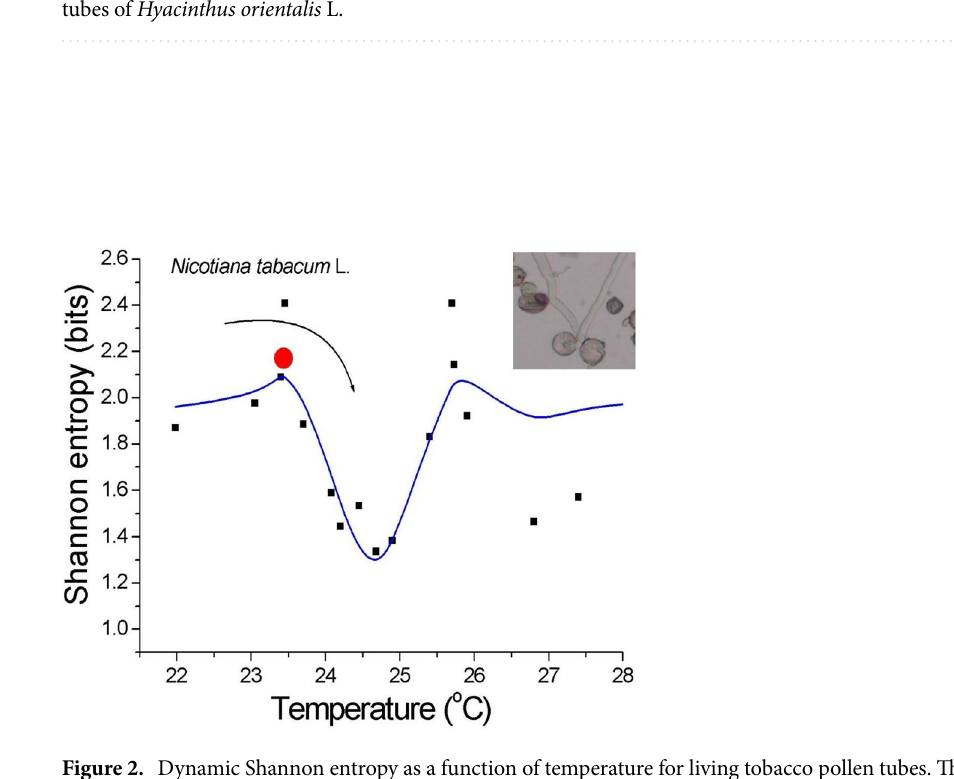
Figure 2. Dynamic Shannon entropy as a function of temperature for living tobacco pollen tubes. The data points (solid squares), calculated separately in the R programming language from the original time series, were interpolated using the sinc function and showed a zero-bias peak and splitting (bound state) at criticality. The red ball with the arrow, representing thermally activated proton over-the-barrier hopping dynamics, points to the attractor basin, which can be interpreted as a 2H + ion(s) energy gap ( (cid:31) ) that was approximately 2.25 K (0.00019(1) eV) wide, which indicated the readiness of the pollen tubes for an extreme (fast) and stable elongation at a critical range. Note the clear local maxima that can be interpreted as potential barriers (the system can tunnel through them to achieve a stable minimum), which also represent points of instability. Fit parameters: coefficient of determination R 2 = 0.62587 ( χ 2 = 0.057), y 0 = 1.95(8), a = − 0.19(5), b = 3.57(6); sin ( bx ) y = y 0 + a x . Photomicrograph of the elongating pollen tubes of Nicotiana tabacum